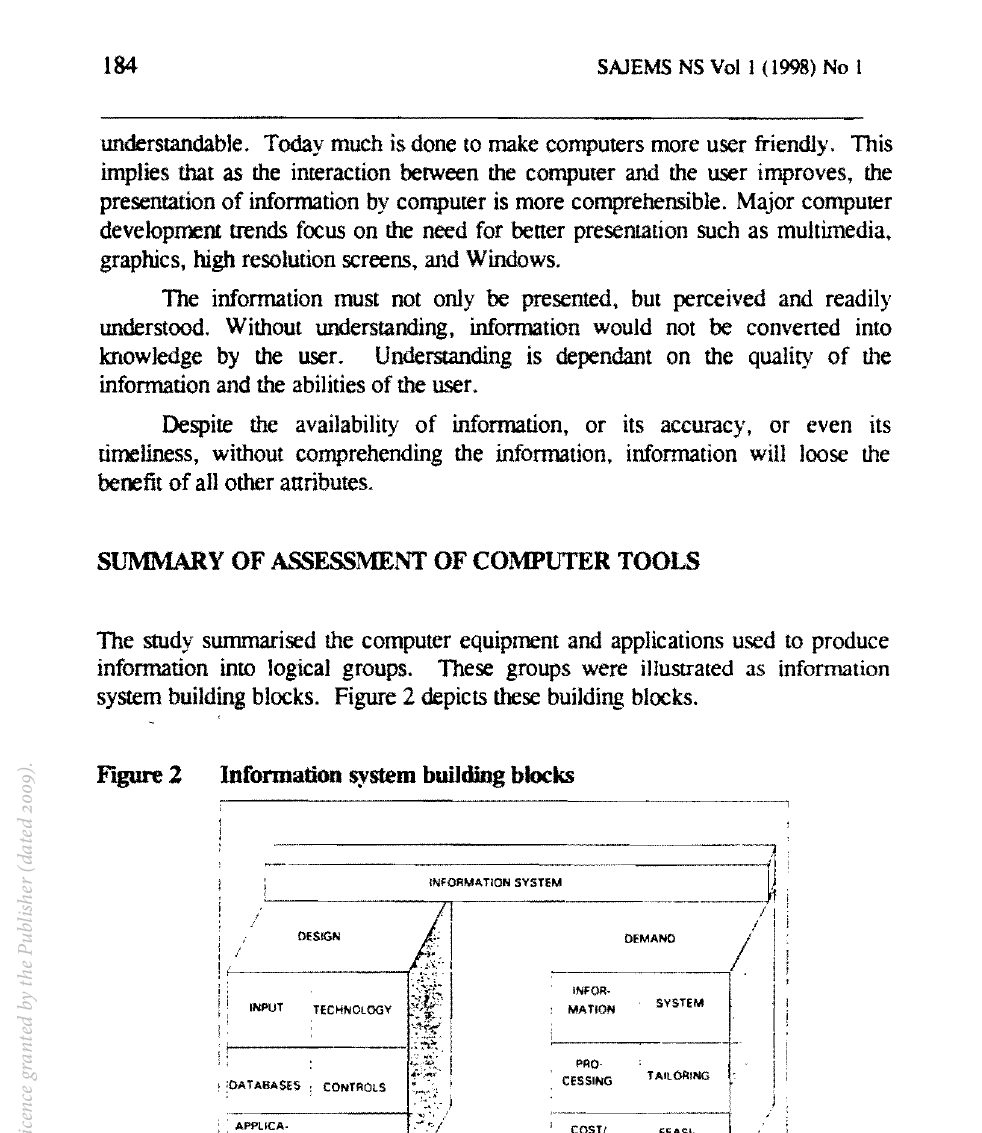
Infonnation system building blocks